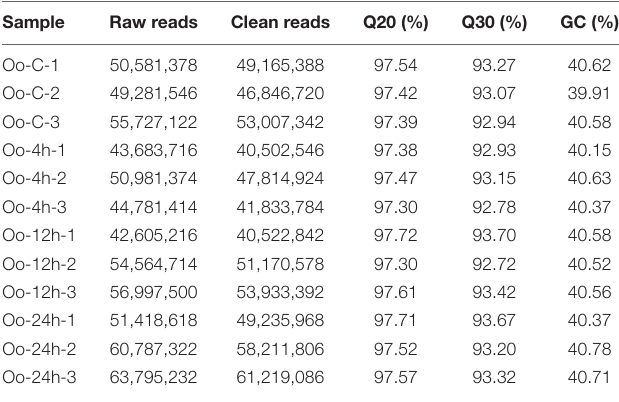
TABLE 2 | Summary of sequencing